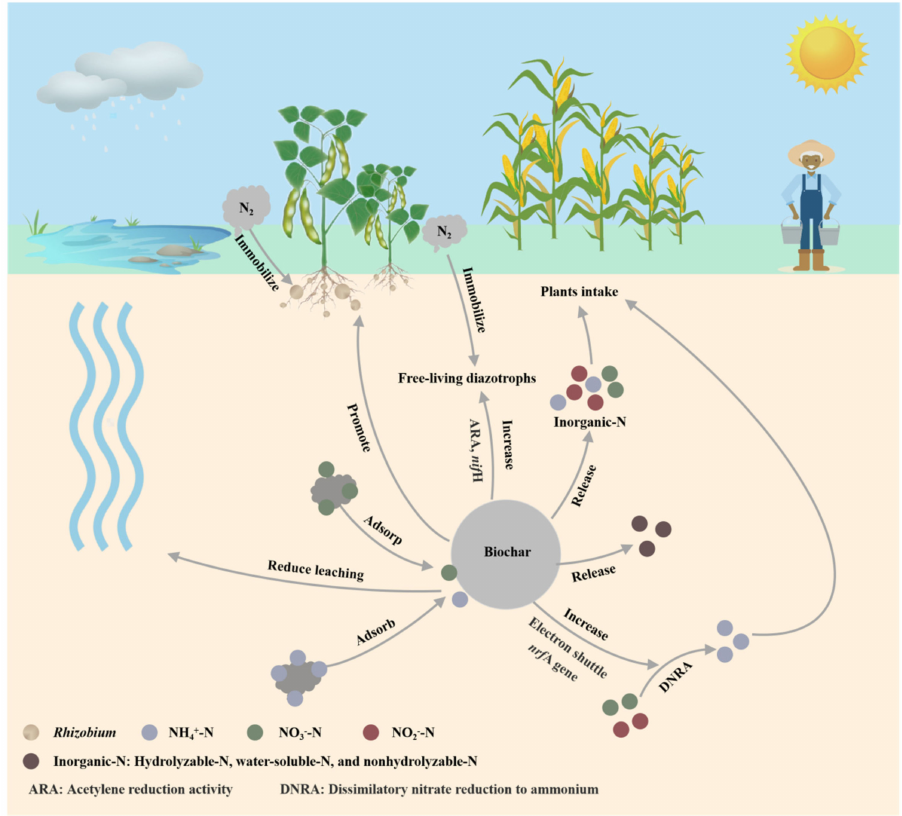
Figure 1. The mechanisms of biochar application on N improvement in soil